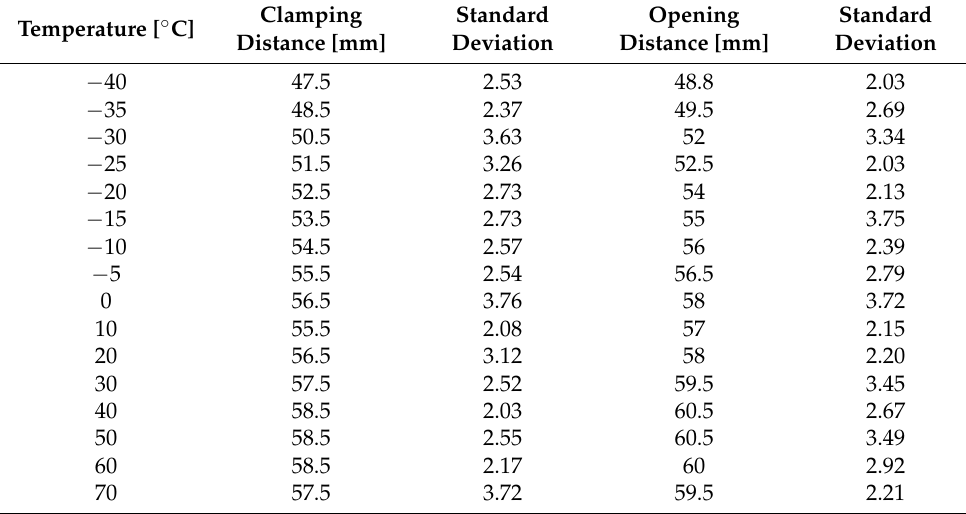
Table 5. USP 500 magnetic contact on and off values during experimental